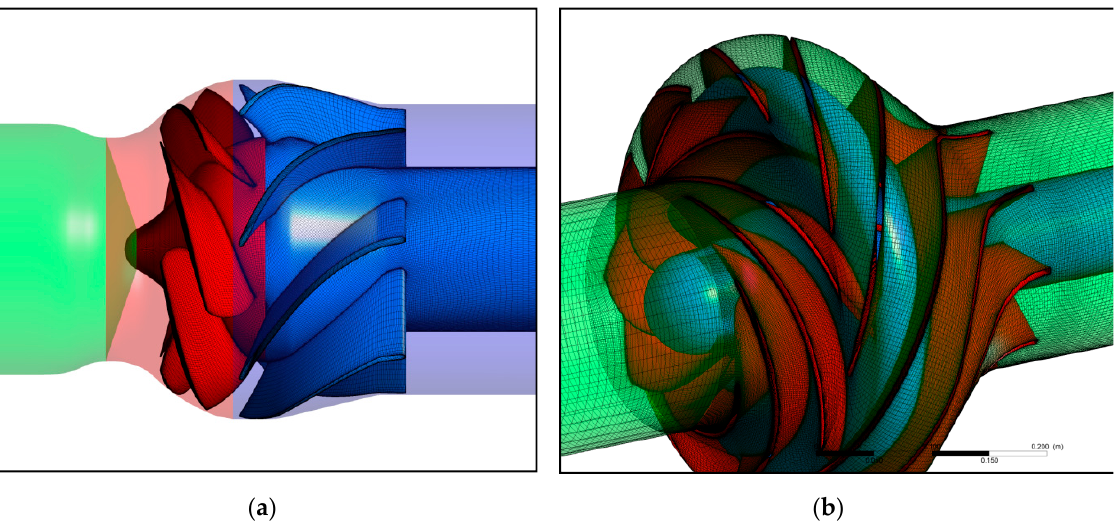
Figure 4. Numerical model for the variable pitch pump ( a ) and the low n q pump ( b ). Table 1. Mesh statistics for final simulations a